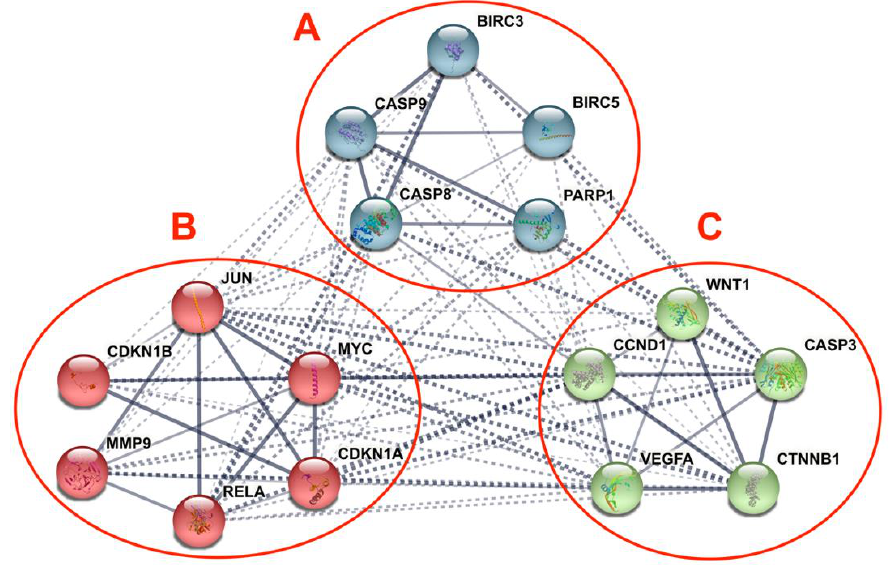
Figure 6. The interaction network of differentially expressed candidate biomarkers (CBs) in human CRC cell lines treated with γT3 or δT3 using STRING, an online bioinformatics software (STRING), which shows protein clusters with high confidence interactions between associated nodes (line thickness indicates the strength of data support). ( A ) CBs involved in apoptosis; ( B ) CBs involved transcriptional dysregulation in cancer; and ( C ) CBs reported being involved in cancer progression pathways.